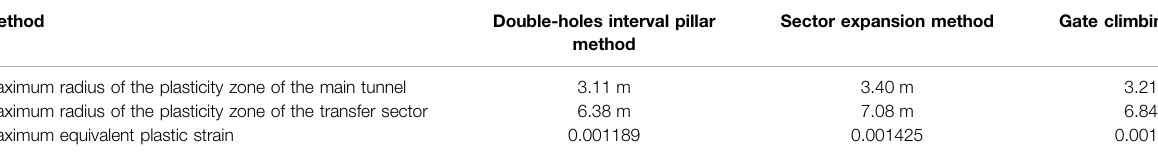
TABLE 4 | Comparison of the plastic zone of surrounding rock after construction.